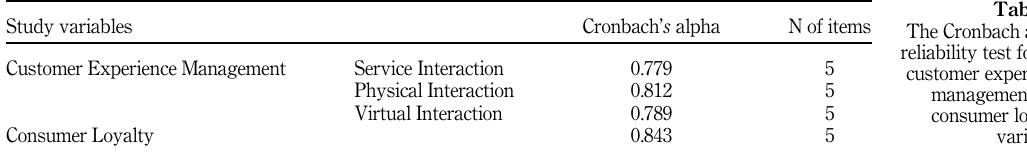
Table 1. The Cronbach